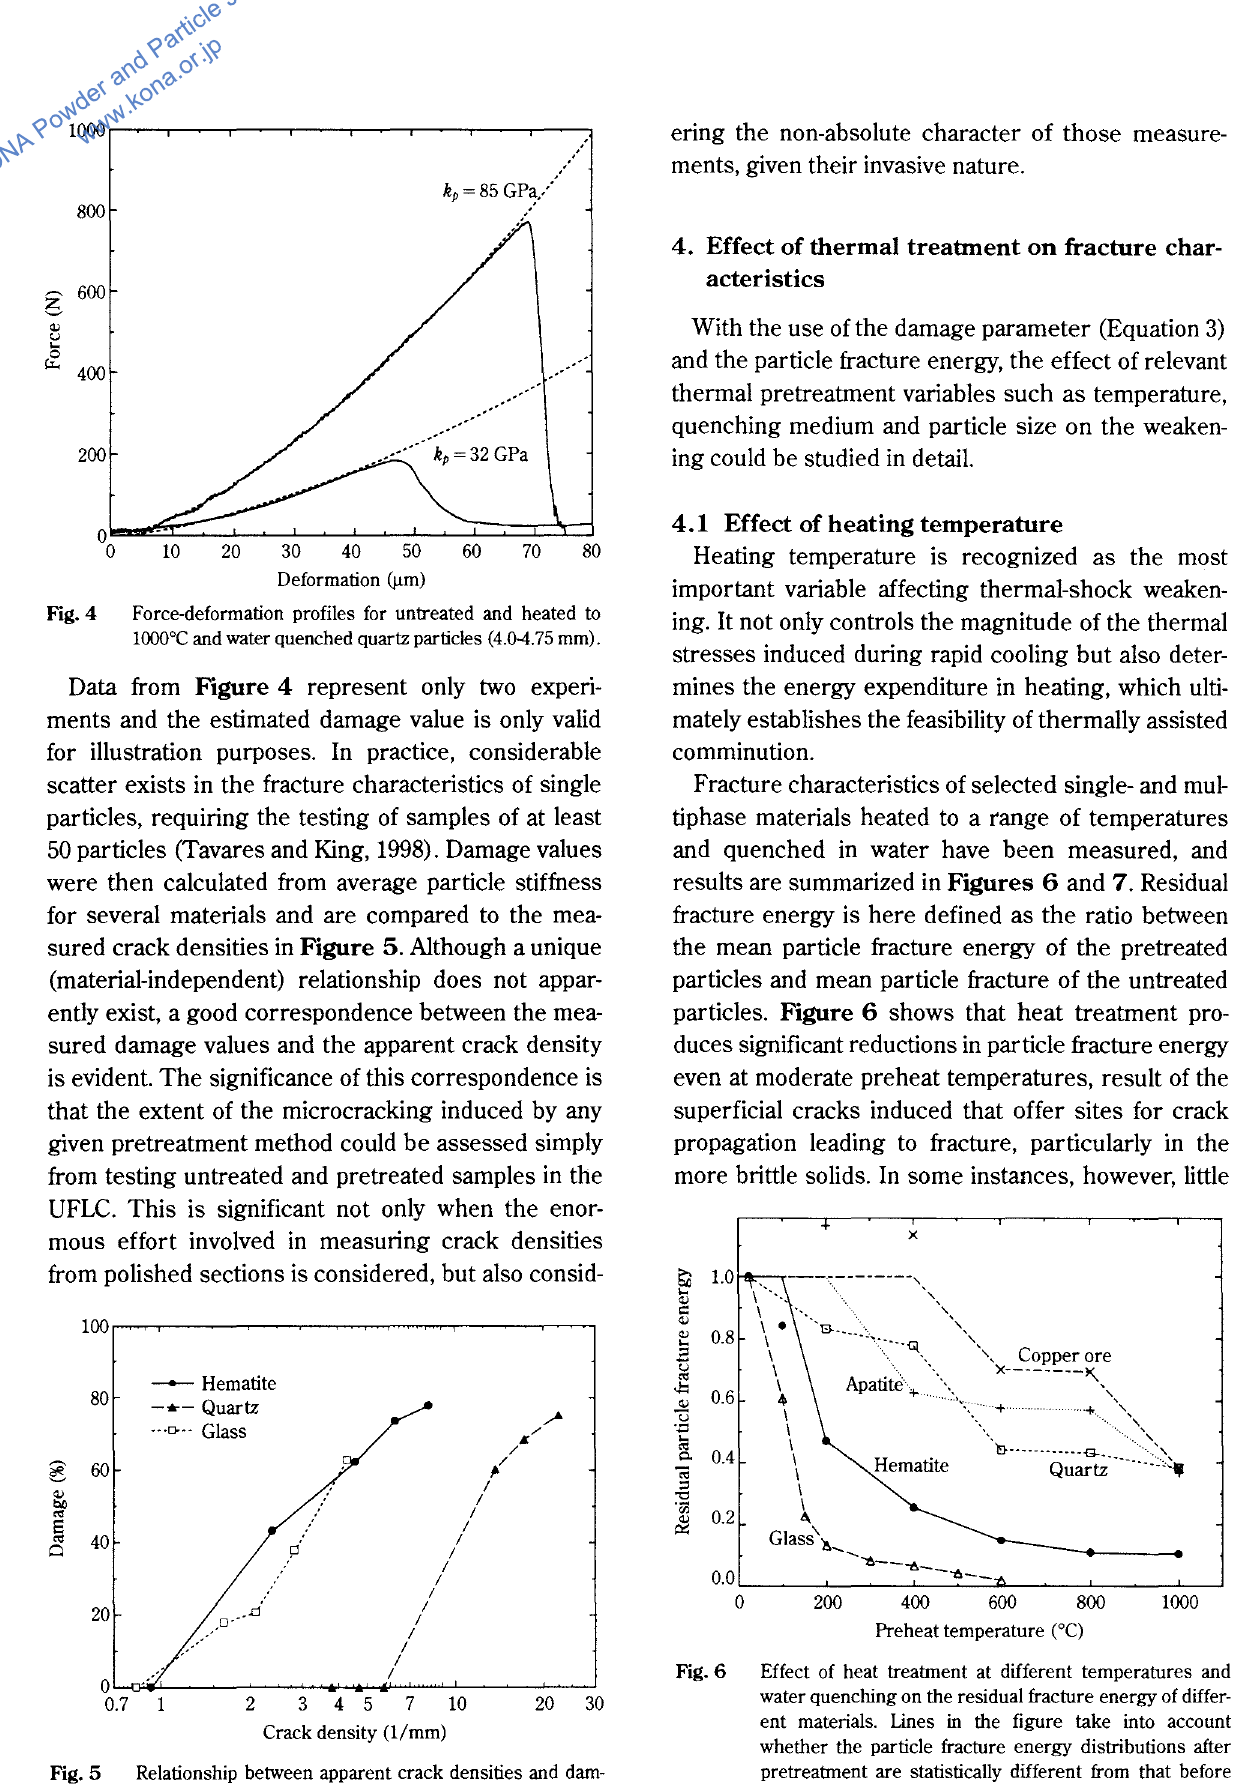
Fig. 5 Relationship between apparent crack densities and dam age parameters of selected materials.